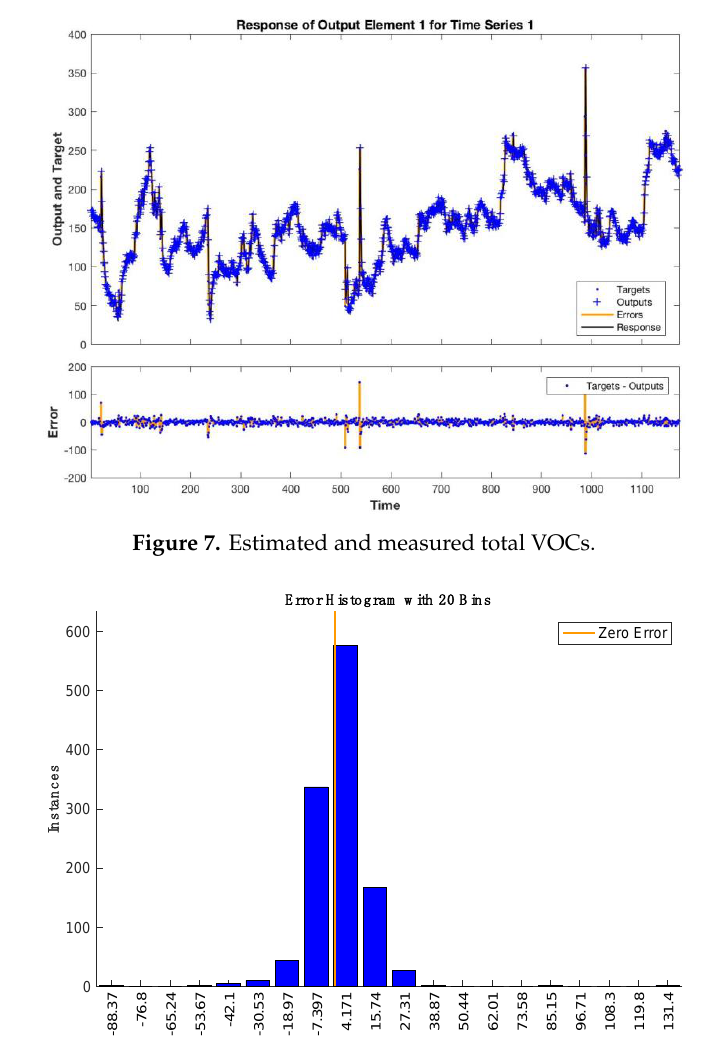
Figure 8. Error histogram during test.